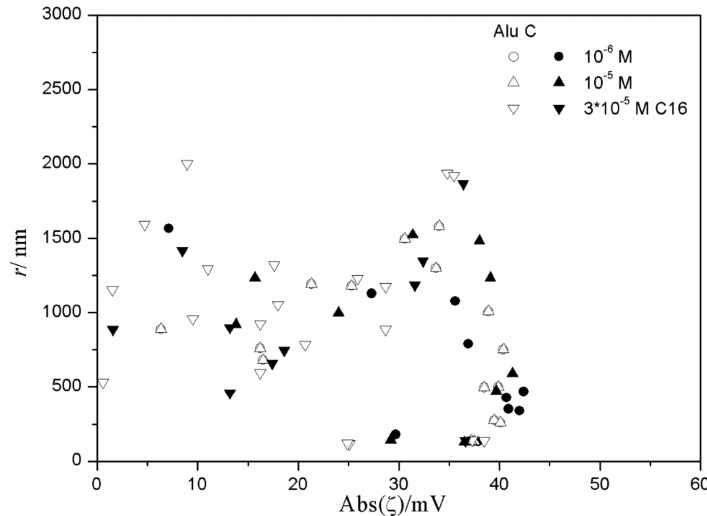
Figure 16. The particle size as a function of | ζ | in fresh (white points) and aged (black points) dispersions of alumina in the presence of sodium